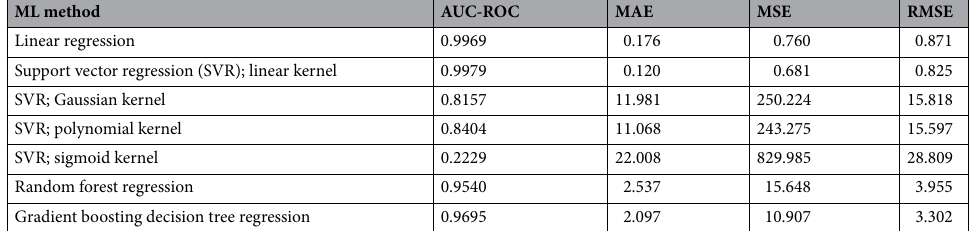
Table 3. The mean absolute error (MAE), mean square error (MSE), root mean square error (RMSE), and area under curve (AUC) of receiver operating characteristics (ROC) of the applied machine learning (ML) regression methods in predicting the grain yield per unit area of the Lallemantia iberica ecotypes with the training of other traits, using the K-fold cross-validation as the data splitting method.